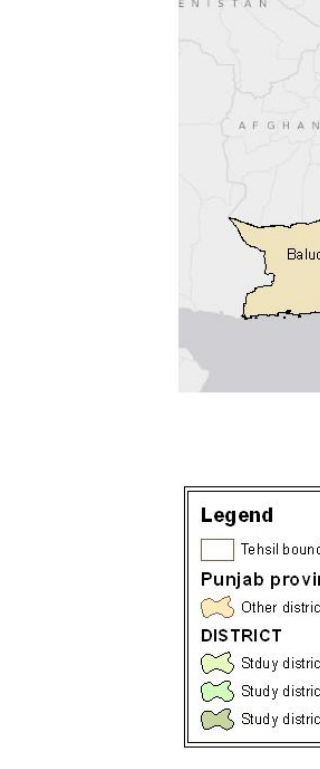
Figure 1. Sample study districts in Punjab province, Pakistan.